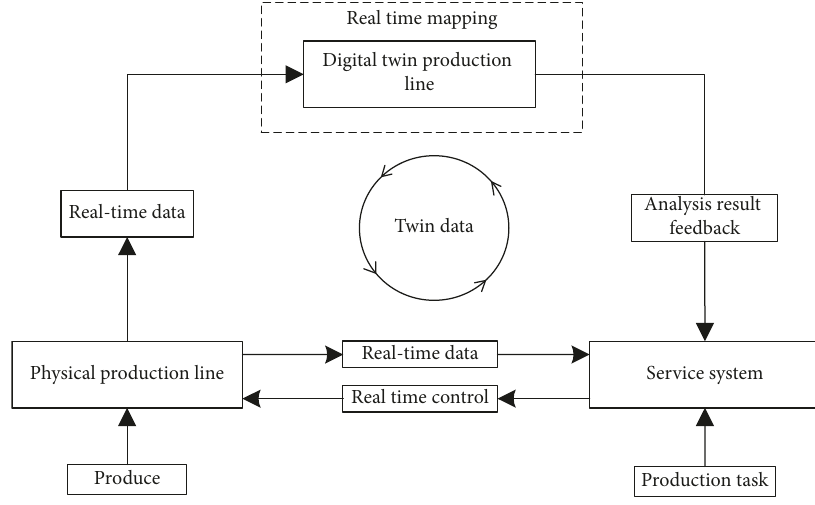
Figure 1: Schematic diagram of the digital twin